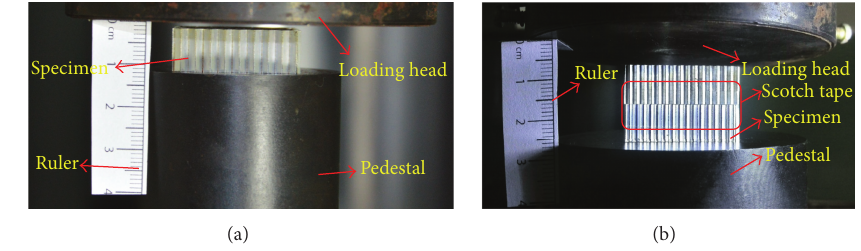
Figure 2: Installation setup in testing. (a) SHAH and (b) CHAH.